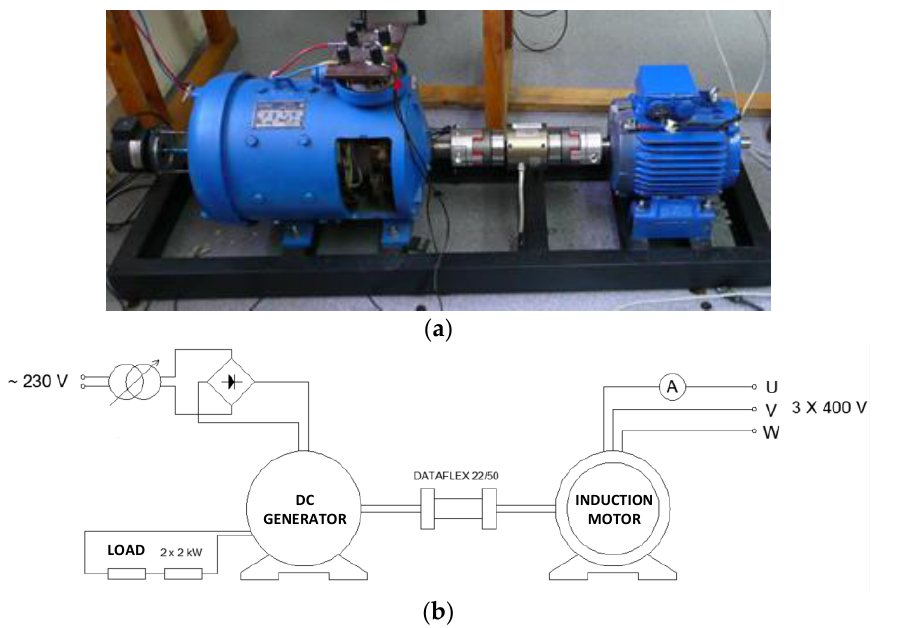
Figure 1. Experimental test rig and setup: ( a ) test rig ( b ); block diagram of the system components and their connections during the simulations.